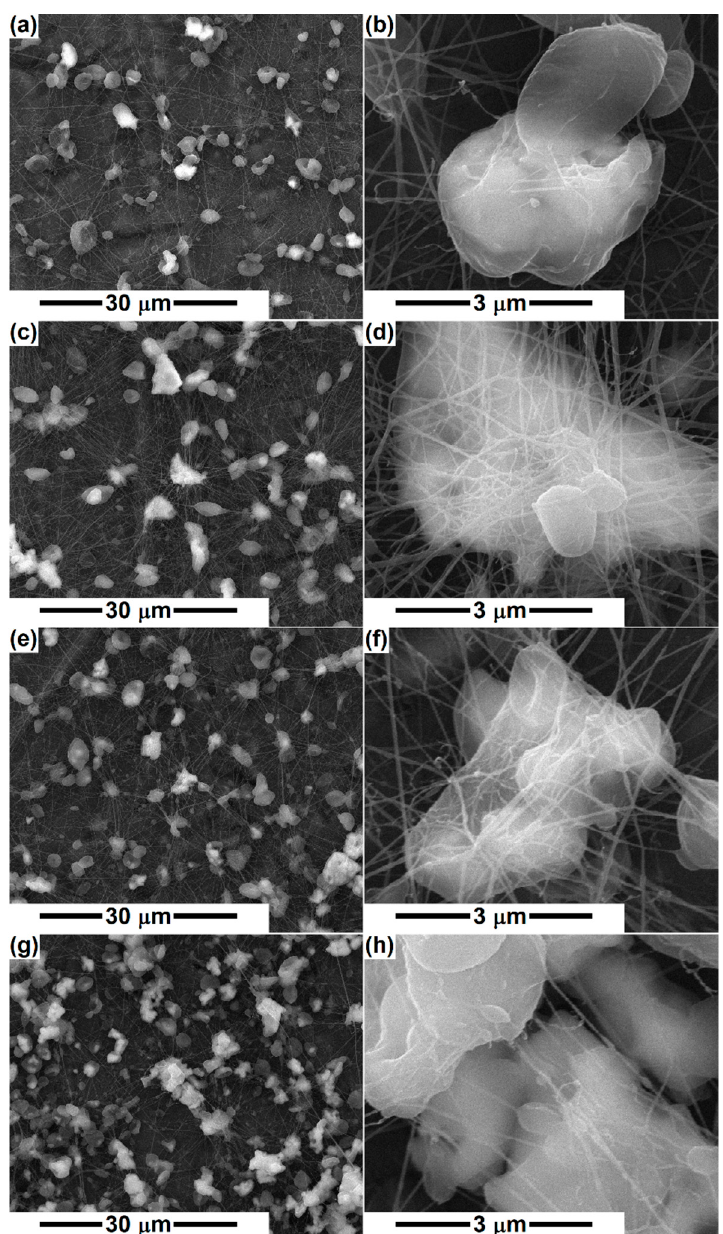
Figure 2. SEM images of the electrospun samples: ( a , b ) PCL-A-5%, ( c , d ) PCL-A-10%, ( e , f ) PCL-M-5%, and ( g , h ) PCL-M-10%.